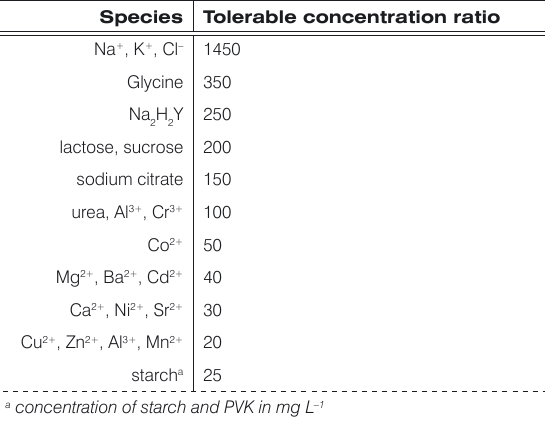
Table 1. Tolerable concentration ratios with respect to 1.0 × 10 -4 M (40 mg L -1 ) PVK for some interfering species